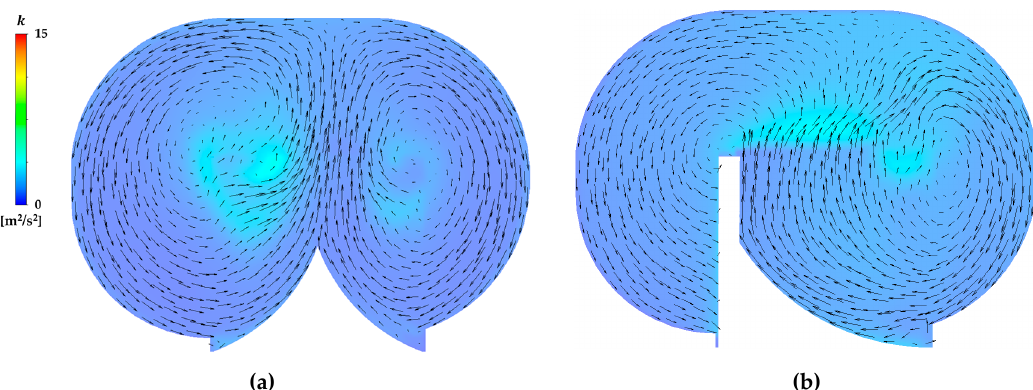
Figure 17. Velocity vectors and turbulence kinetic energy on the perpendicular plane to the rotational direction at θ = 0°: ( a ) reference pump; ( b ) optimized pump.